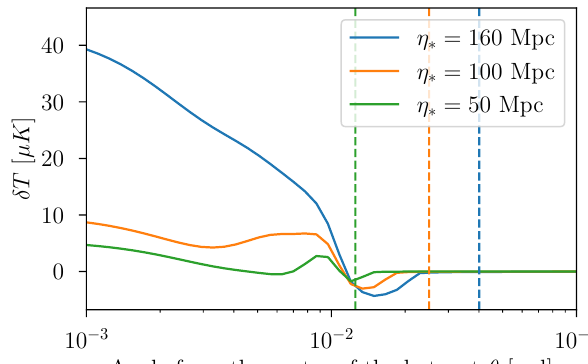
Figure 4 . Angular profile of a hotspot for three different choices η ∗ = 160 , 100 , 50 Mpc based on eq. (3.18). The vertical lines denote the angular size of the corresponding hotspots and is related √ to η by, θ = 4 πη . Here we have set g = 1 ∗ ∗ ∗ /η 0